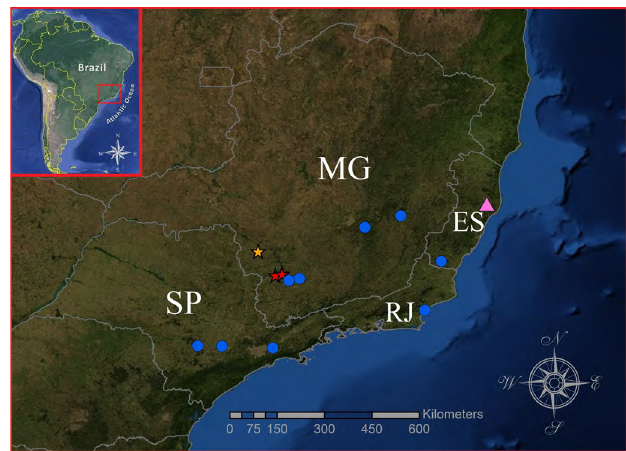
Adenomera thomei . Pink